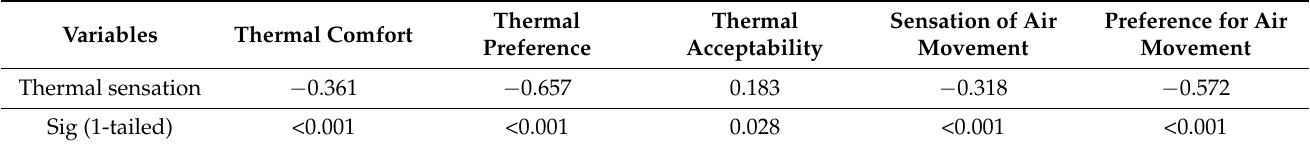
Table 5. Summary of the Pearson correlations between the variables assessed during the surveys (N =